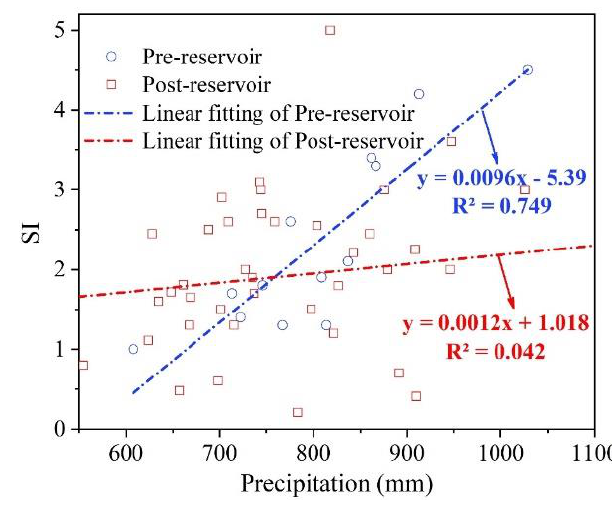
Figure 9. Relationship between SI and precipitation.